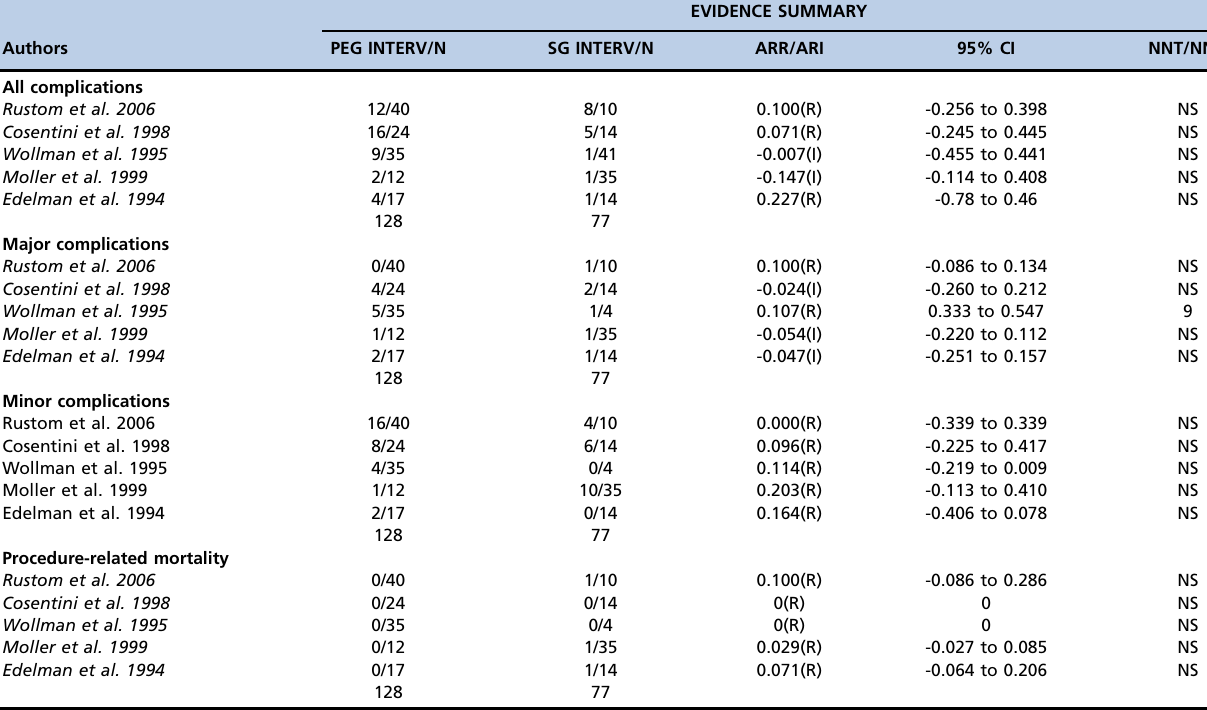
Table 2 - Statistical summary of complications and mortality for retrospective studies.